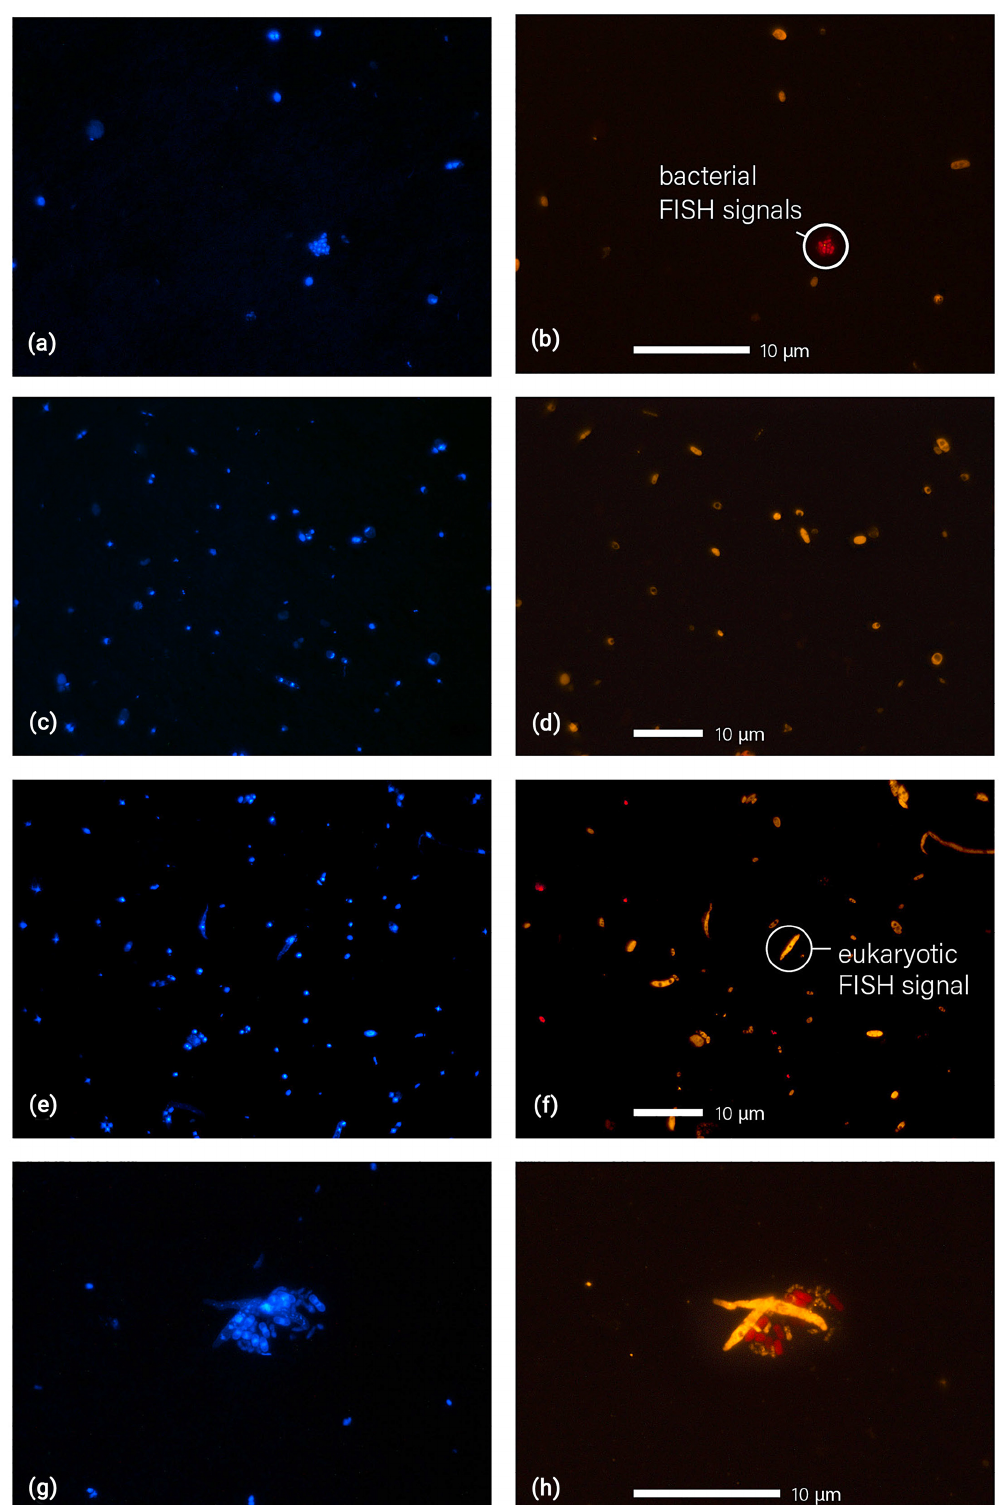
Figure 5. Microscopic images of fluorescence signals after DNA staining with DAPI ( a, c, e, g , blue) and FISH ( b, d, f, h , eukaryotes in orange and bacteria in red). Filter samples displayed here were collected at 325m (a, b) , 60m (c, d) , and 5m (e, f, g, h) . Particle agglomerates, as shown in (g) and (h) , were found rather rarely. The agglomerate here shows a cluster of fungal spores and bacterial